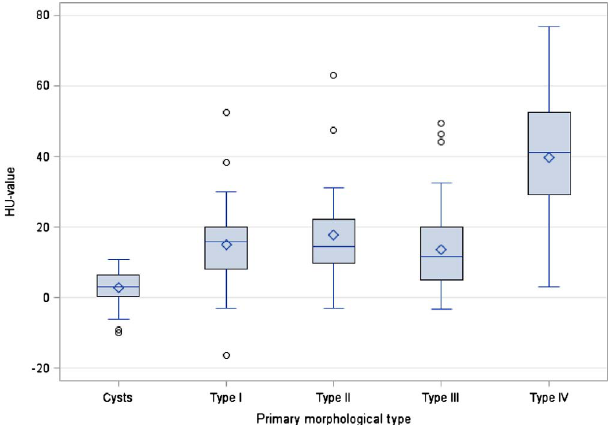
Figure 3. Box plot showing the HU values and spread of the EMUC-CT primary morphological types and cysts.